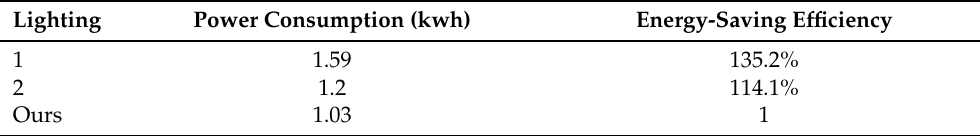
Table 4. Power consumption